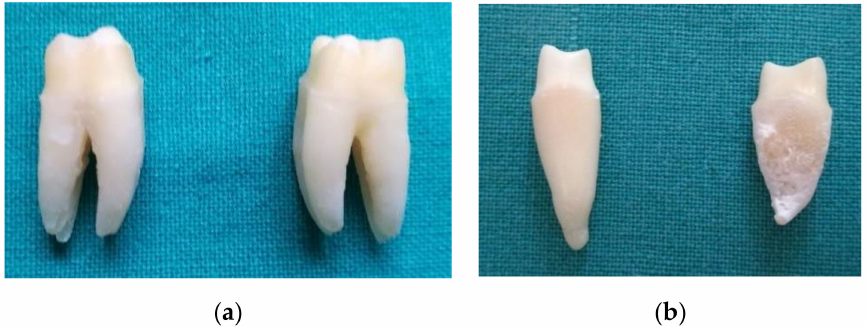
Figure 2. Samples 1, 2, 3, and 4 after shaping: ( a ) prepared mandibular molars; ( b ) prepared mandibular premolars.